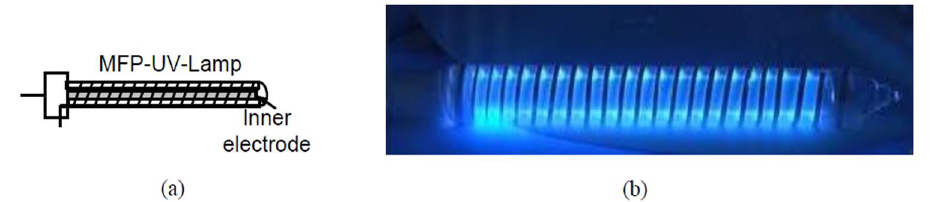
Figure 1. ( a ) Schematic view of MFP-UV-lamp and ( b ) Actual view of